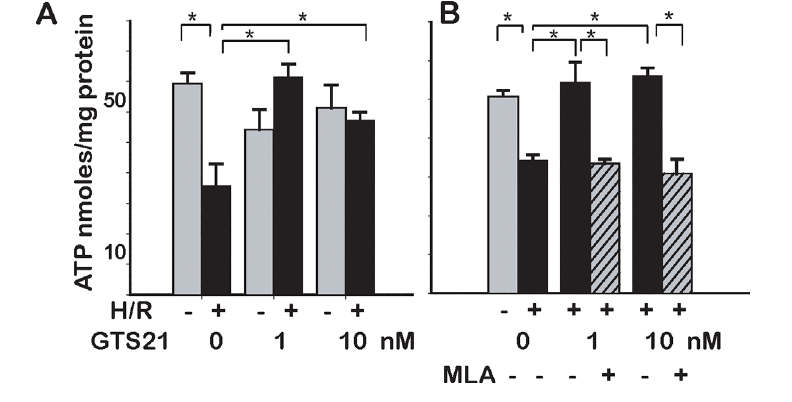
Figure 7. Effects of GTS21 on intracellular ATP. AC16 cells were exposed to 6-h hypoxia followed by 1-h reoxygenation (H/R)(+) or cultured under normoxia (-) conditions. Cellu- lar ATP content was measured using a luciferase assay and normalized to total protein. (A) Cells were treated with GTS21 (1, 10 nM) only during reperfusion. (B) Pretreatment with MLA (100 nM) abolished the GTS21 effect on H/R cells. Data (mean ± SE) represents n = 3–6 cell culture dishes/treatment group. Each ATP assay data point was done in triplicate. Significance was determined by ANOVA post hoc Newman-Keuls; * p < 0.01 differences between groups as indicated by the connecting